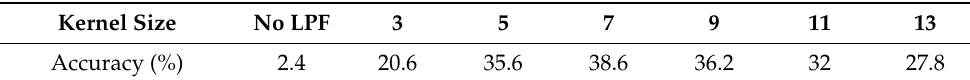
Table 4. Accuracy when applying an LPF to adversarial example of (cid:101) = 16. Kernel Size